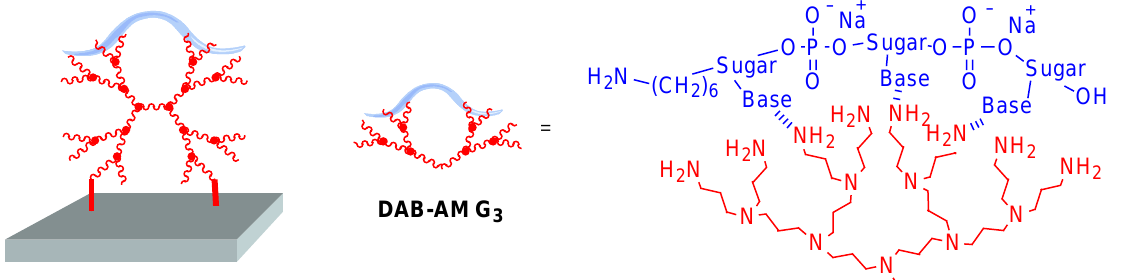
Figure 6. Presumed type of supramolecular interaction between an oligonucleotide and the end groups of DAB-AM dendrimers.